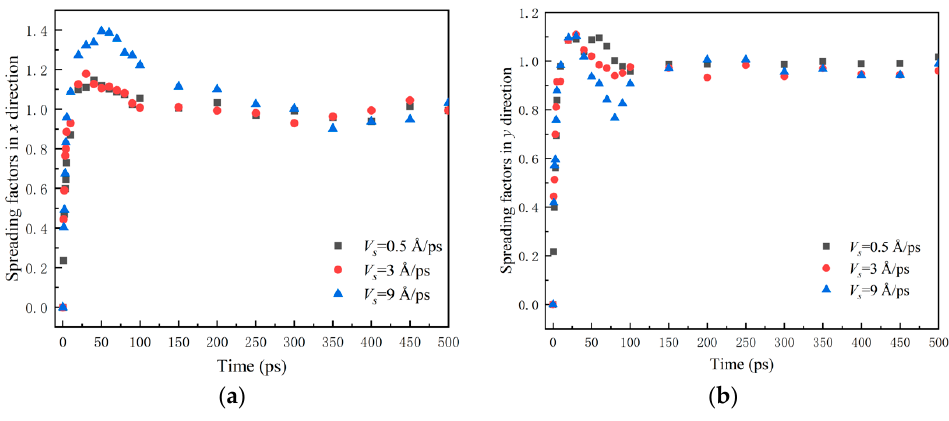
Figure 8. Time evolution of spreading factors in x and y directions: ( a ) β x ; ( b ) β y .